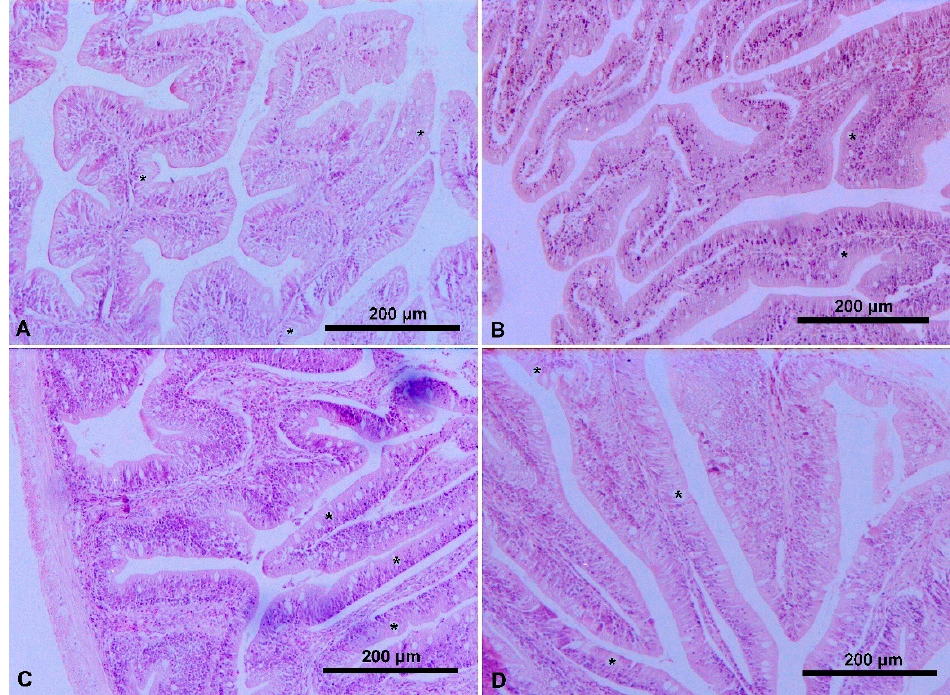
Figure 4. Midgut histopathological examination of S. aurata fed on HFM diets. ( A ) fish fed FM diet; ( B ) fish fed HFM50 diet; ( C ) fish fed HFM25 diet; ( D ) fish fed HFM50+ diet. In all images, the gut structure appeared normal with goblet cells (*) present.